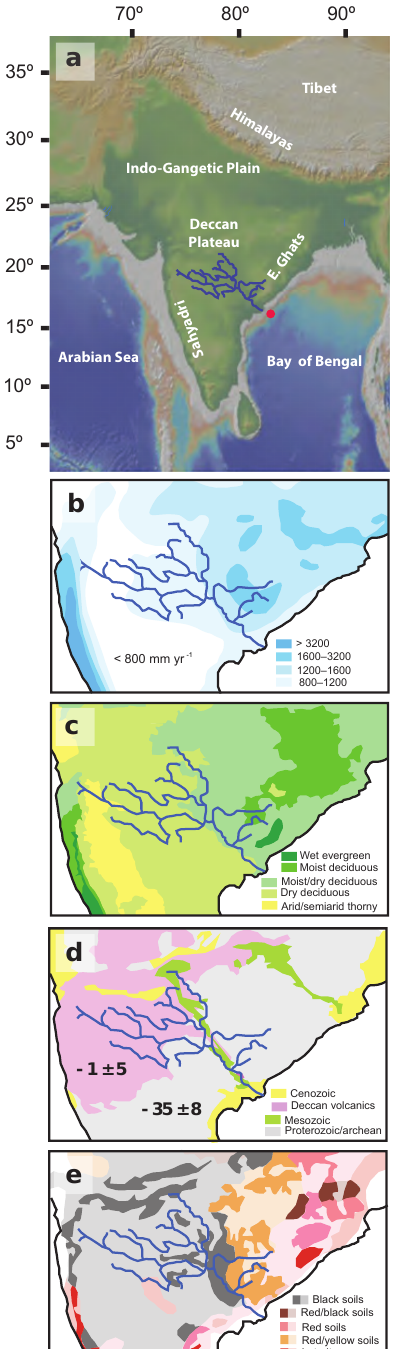
Figure 1. Godavari River drainage basin in its (a) physiographical, (b) hydroclimatic (Asouti and Fuller, 2008), (c) ecological (Asouti and Fuller, 2008), (d) geological (Bikshamaiah and Subramanian, 1988) and (e) soil cover (NBSS & LUP, 1983) context. Core NGHP- 01-16A location is indicated in (a) by the red dot. Average bedrock ε Nd values are shown in (d)